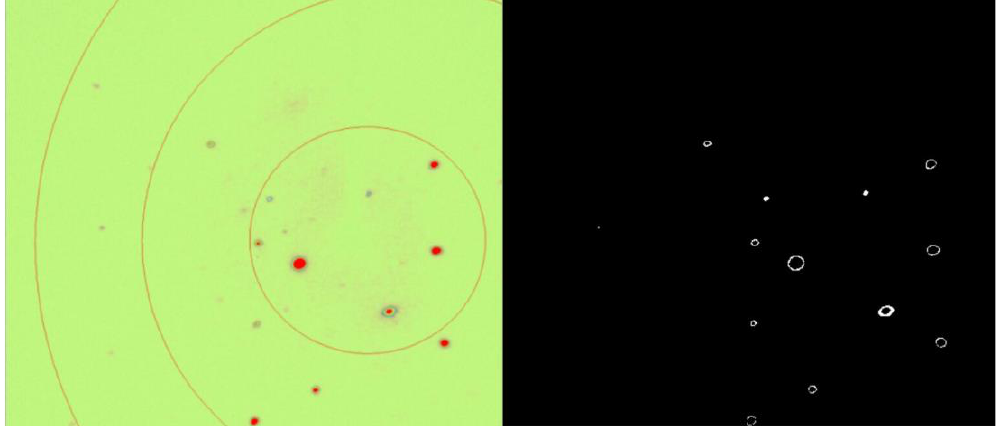
Figure 8. Color segmentation on diffraction image to achieve the best segmentation effect.